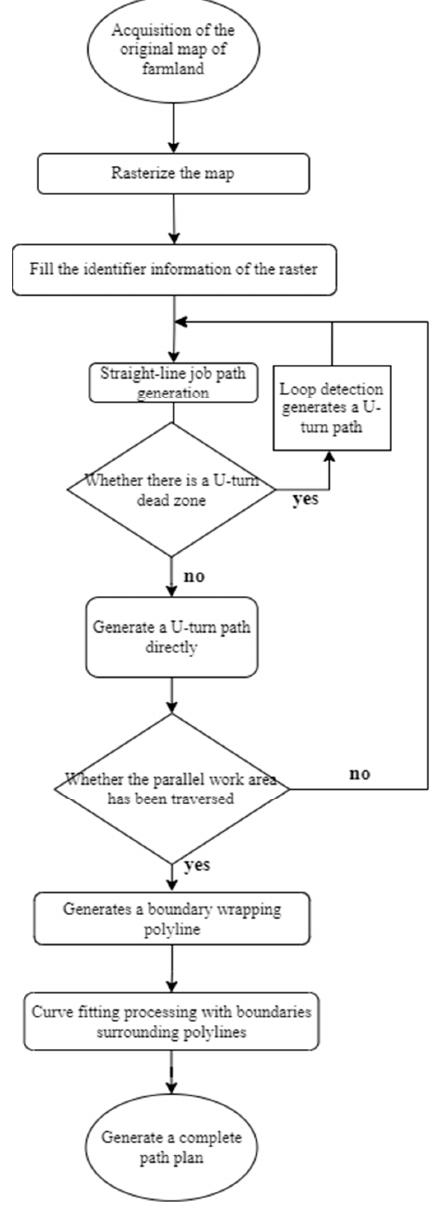
Figure 2. Algorithm flowchart.